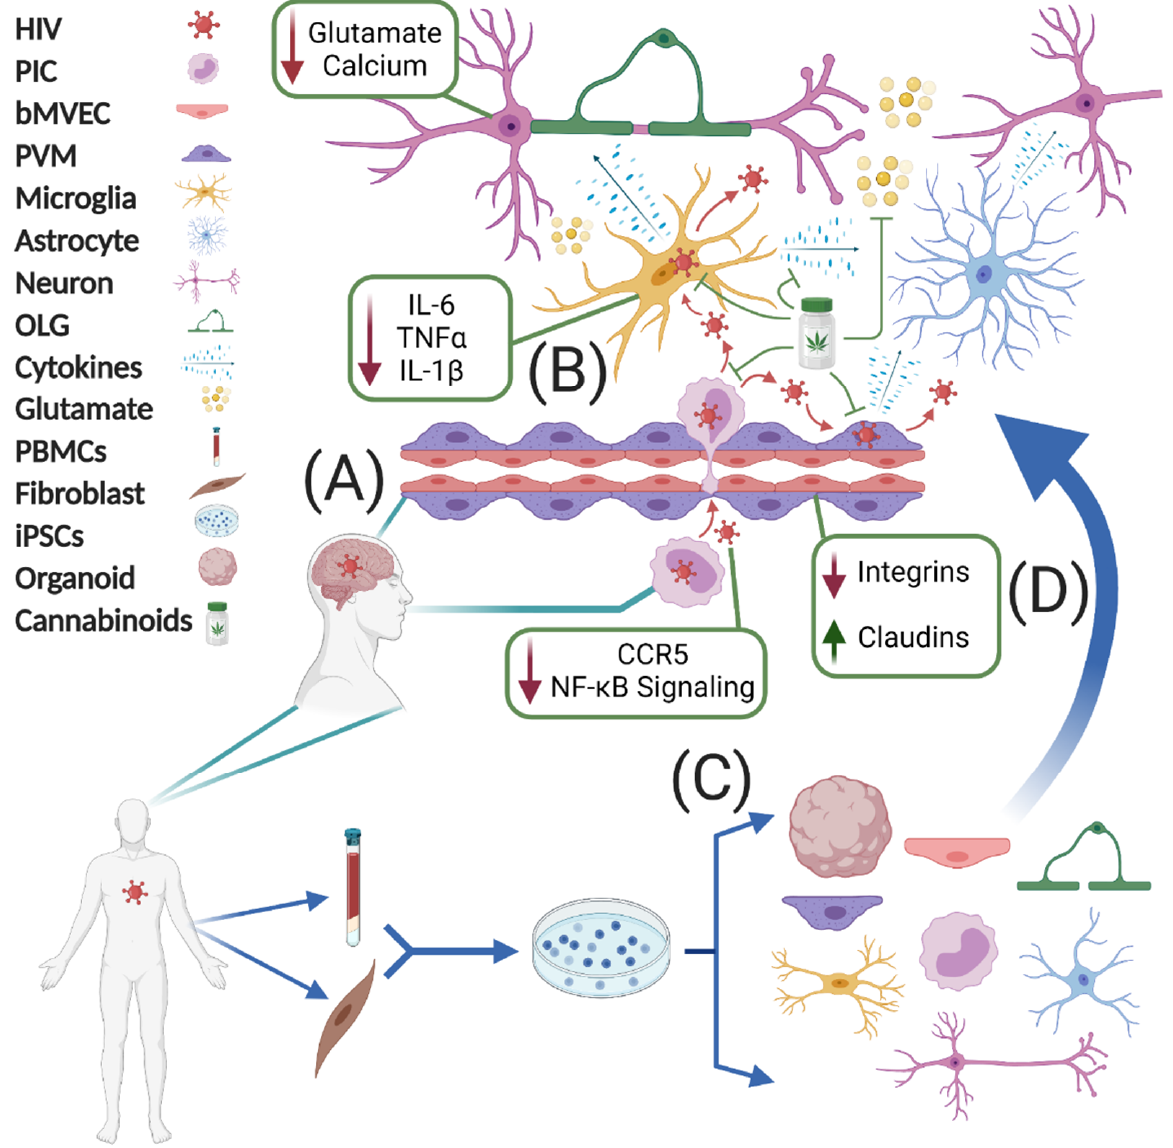
Figure 1. Human iPSCs can model the multicellular actions of cannabinoids in neuroHIV. ( A ) HIV crosses the BBB, infecting macrophages and microglia. This results in a cascade of proinflammatory activation and excitotoxicity that manifests as HAND. ( B ) Cannabinoids are uniquely suited to counter the two primary HIV-associated neurotoxic mechanisms by modulating neurotransmission and suppressing inflammation. Green boxes indicate molecular mechanisms through which cannabinoids counter HIV neuropathology at various sites of action. ( C ) Recent advances in iPSC technology allow for both 2D and 3D human models of many CNS cell types. ( D ) Combining iPSC-derived CNS cells and exposing them to HIV and cannabinoids provides a platform to study common HAND comorbidities in a holistic, human context. Abbreviations: HIV, human immunodeficiency virus-1; HAND, HIV-associated neurocognitive disorders; PIC, peripheral immune cell; bMVEC, brain microvascular endothelial cell; PVM, perivascular macrophage; OLG, oligodendrocyte; PBMC, peripheral blood mononuclear cell; iPSC, induced pluripotent stem cell. Created with BioRender.com.